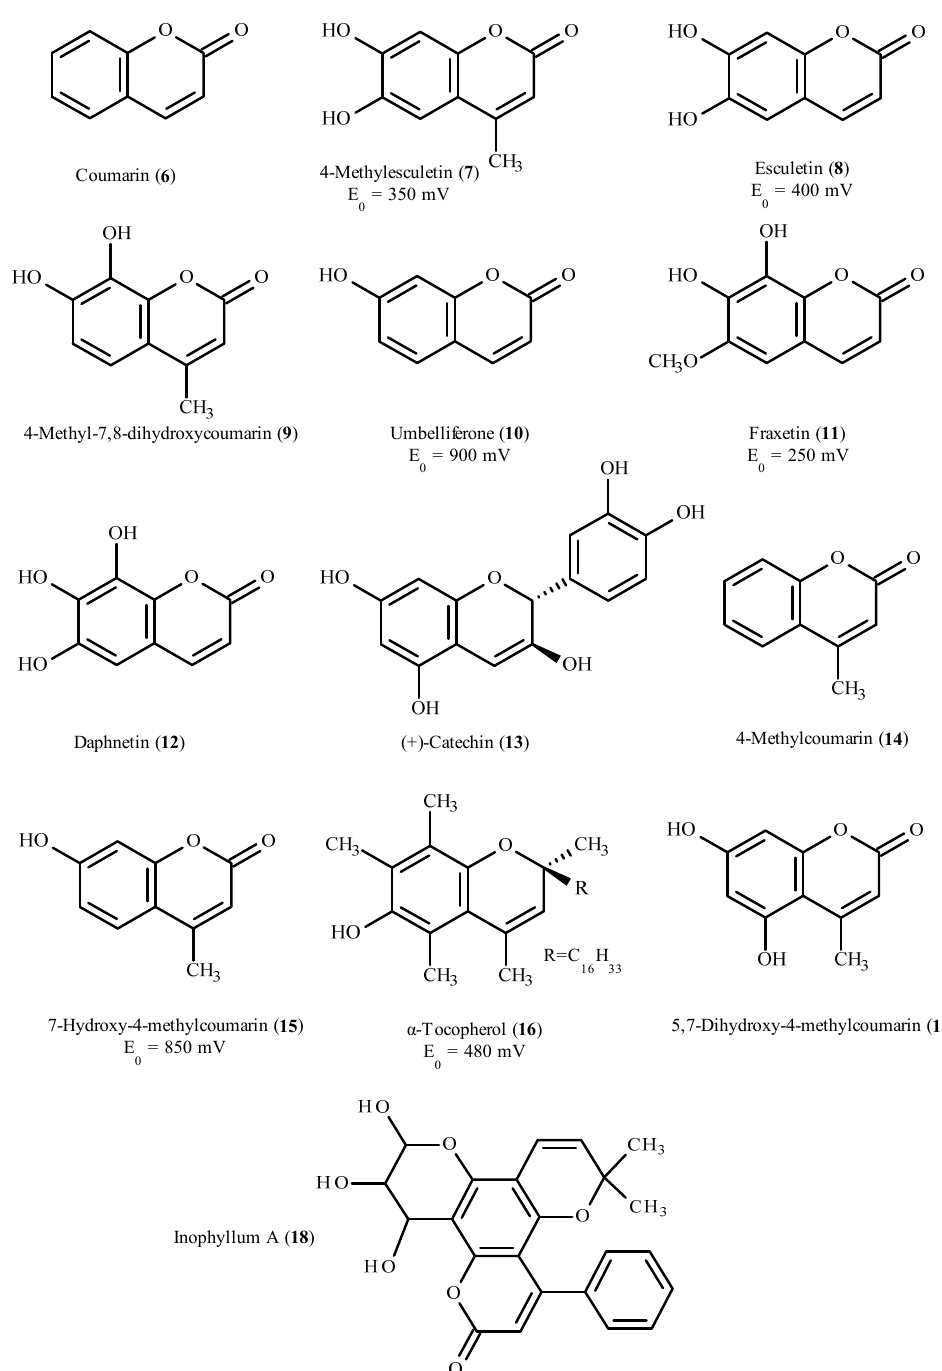
Figure 2. Structures of compounds mentioned in Section 5.2. and the oxidative potential (E o [mV]) values of selected coumarins.